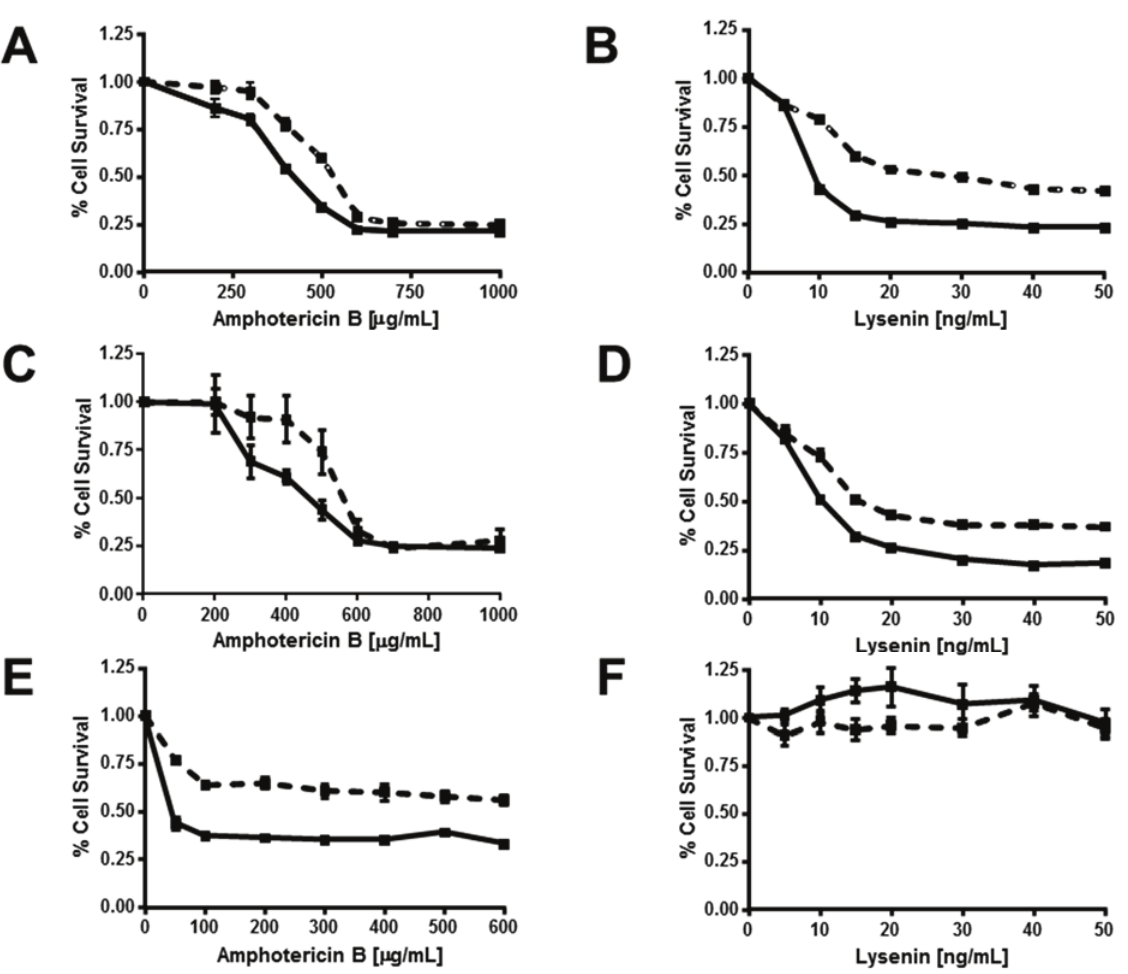
Figure 7. ABCG1 confers resistance to both amphotericin B and lysenin-mediated cytolysis. Control ( solid lines ) and ABCG1 cells ( dashed lines ) not pre-treated ( A , B ), or, pre-treated with exogenous SM ( C , D ), or, pre-treated with myriocin ( E , F ) were assayed for cell viability with varying doses of the FC-binding toxin amphotericin B ( A , C , E ), or the SM-binding toxin lysenin ( B , D , F ), as described in “Experimental Section.” Values are expressed as mean + S.E.M. Data shown is representative of at least three replicate experiments. Two-way ANOVA analyses using multiple comparisons revealed that ABCG1 expression significantly increased the percent Cell Survival at amphotericin B concentrations of ( A ) 200, 300, 400, and 500 μg/mL ( p = 0.02, p < 0.0004, p < 0.0001, and p < 0.0001, respectively; ( C ) 200, 300, 400, and 500 μg/mL ( p = 0.003, p < 0.0001, p < 0.0001, and p < 0.0001, respectively; ( E ) at all concentrations, p < 0.0001. Two-way ANOVA analyses using multiple comparisons revealed that ABCG1 expression significantly increased the percent Cell Survival at lysenin concentrations of 10–50 ng/mL ( p < 0.0001) for ( B ) and ( D ). None of the values in ( F ) were significantly different (range p < 0.1954 to p <